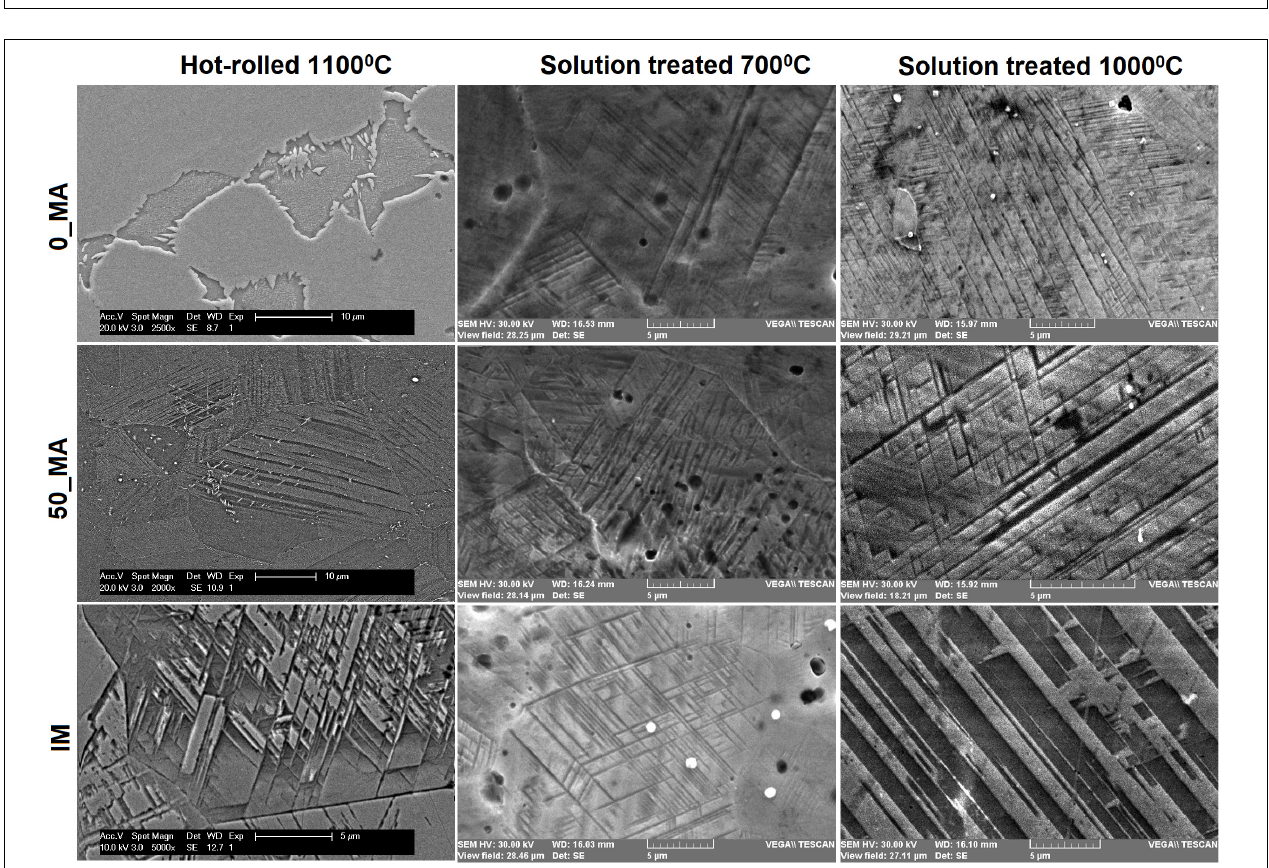
FIGURE 5 | SEM micrographs illustrating the evolution of initial hot rolled structure of P/M specimens sintered from pressed as blended powders (0_MA), 50% as blended powders substituted with MA’ed powders (50_MA) and ingot metallurgy specimens (14 Mn), which were subjected to solution treatments at 700 and 1,100 ◦ C (adapted after Pricop et al., 2015a, © owned by the authors).